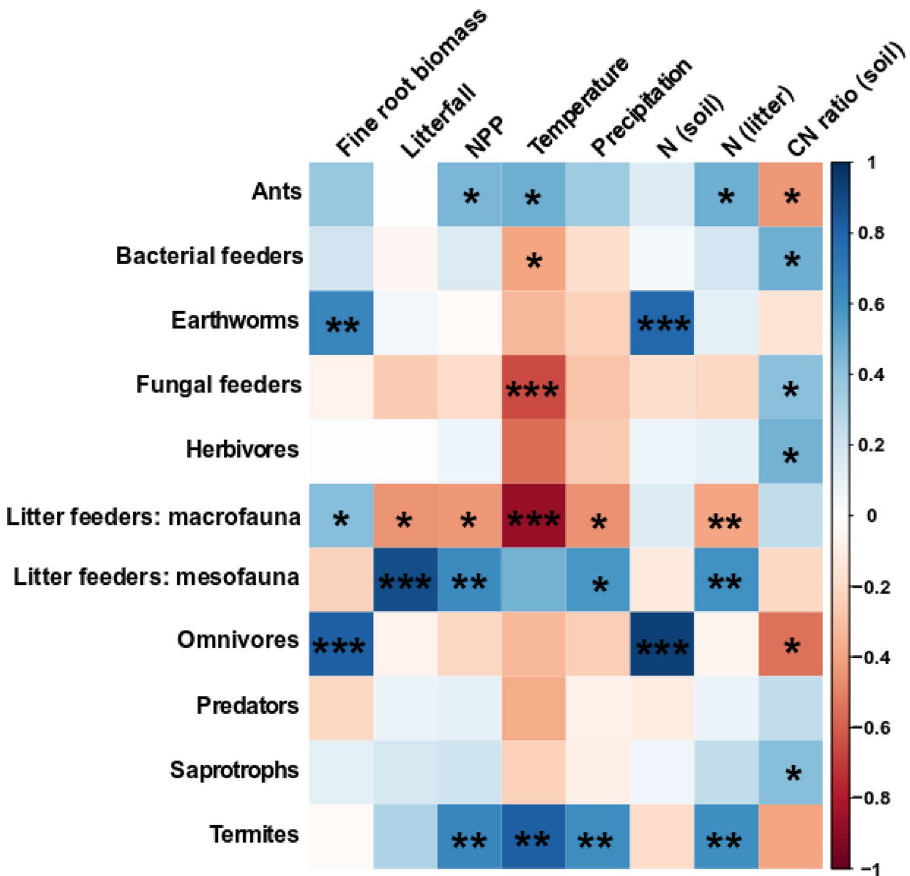
Figure 3. Heatmap of Pearson’s correlation coefficients for the relationships between the biomass of soil fauna by functional group and the following variables: fine root biomass, litterfall, net primary production (NPP), mean annual temperature (MAT), mean annual precipitation (MAP), N content of soil, N content of litter, and the litter C:N ratio. Asterisks indicate significant correlations: *, **, and *** indicate p < 0.05, < 0.01, and < 0.001, respectively. Bonferoni corrections were used to adjust p value of multiple correlations. Blue color indicates positive correlation. Red color indicates negative